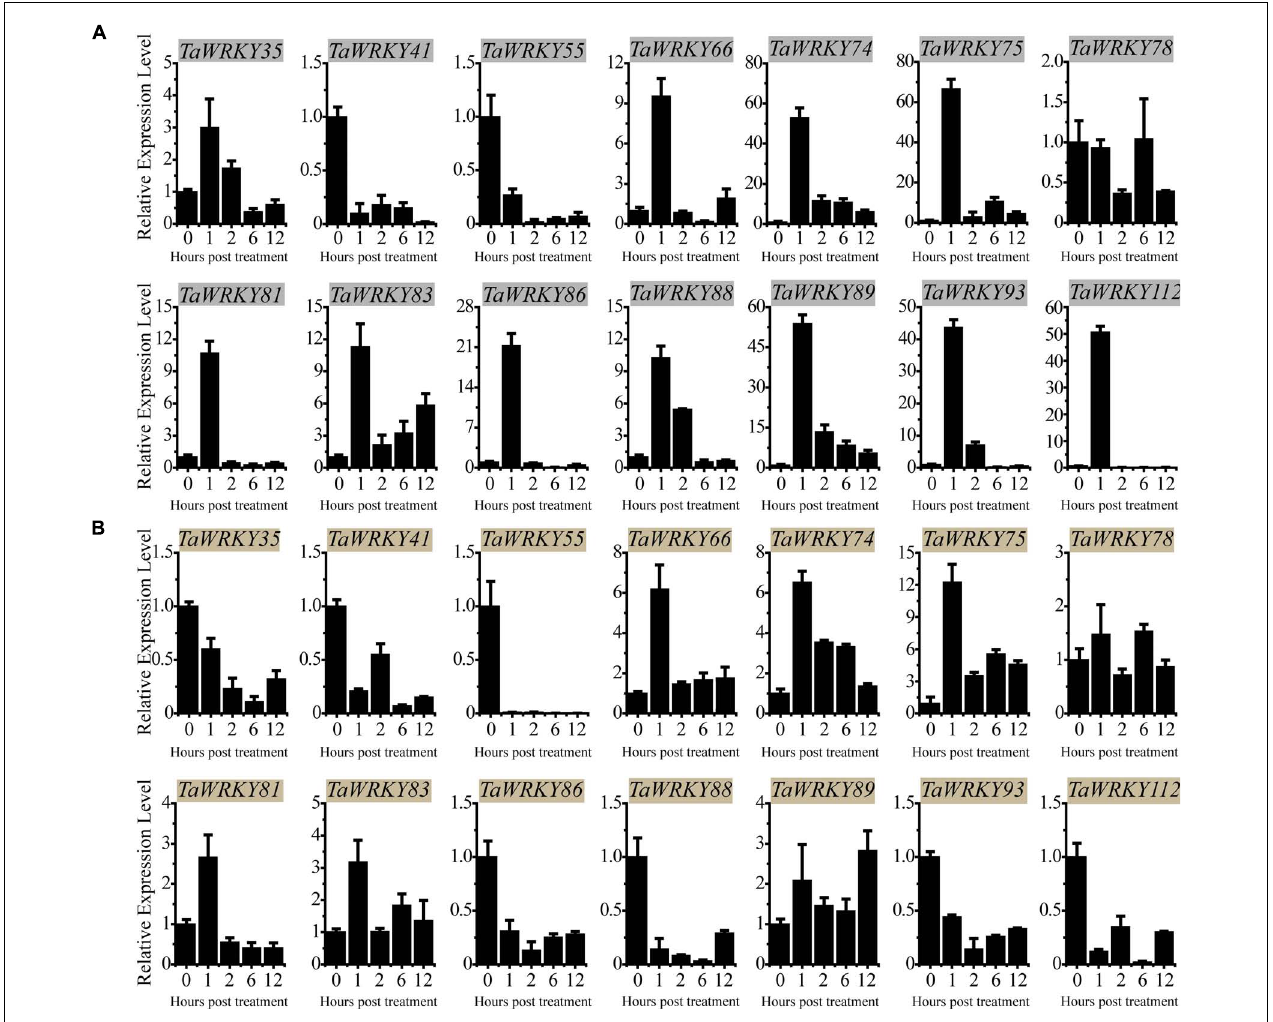
FIGURE 4 | qRT-PCR assay-based expression patterns of 14 selected TaWRKY genes in 2-week-old wheat leaves under polyethylene glycol (A) and salt (B) stresses. All experiments were replicated three times, and the relative expression levels are normalized with wheat 18S-rRNA gene. Bars indicate mean ±